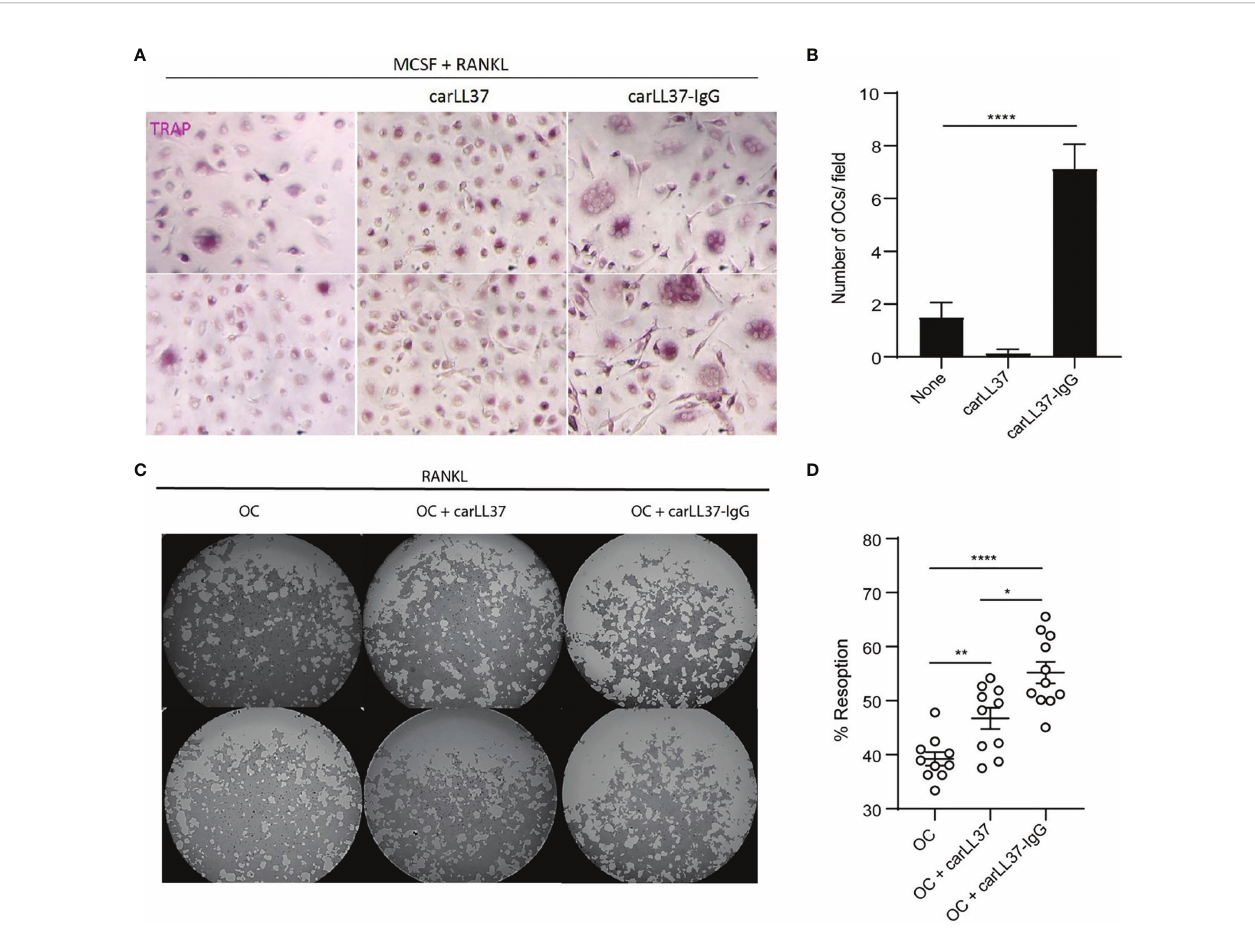
FIGURE 4 | CarLL37-IgG immune complexes enhance osteoclast formation and function. (A) Representative pictures of M-CSF/RANKL-mediated osteoclastogenesis in the presence or absence of anti-carbamylated LL37 IgG immune complexes. Original magni fi cation is 400X. (B) Quanti fi cation of TRAP-positive multinucleated cells. Results are the mean +/- SEM of 4-5 independent experiments. Kruskal-Wallis test was used. ****p < 0.0001. (C) Representative pictures of resorption pit (white areas) assay of equal number of M-CSF/RANKL generated osteoclasts (OC) in the presence or absence of anti-carbamylated LL37-IgG immune complexes in a calcium-phosphate plate. (D) Percentage of eroded surface using ImageJ. Results are the mean +/- SEM of 10 independent experiments. Mann-Whitney U-test was used. *p < 0.05, **p < 0.01, ****p <